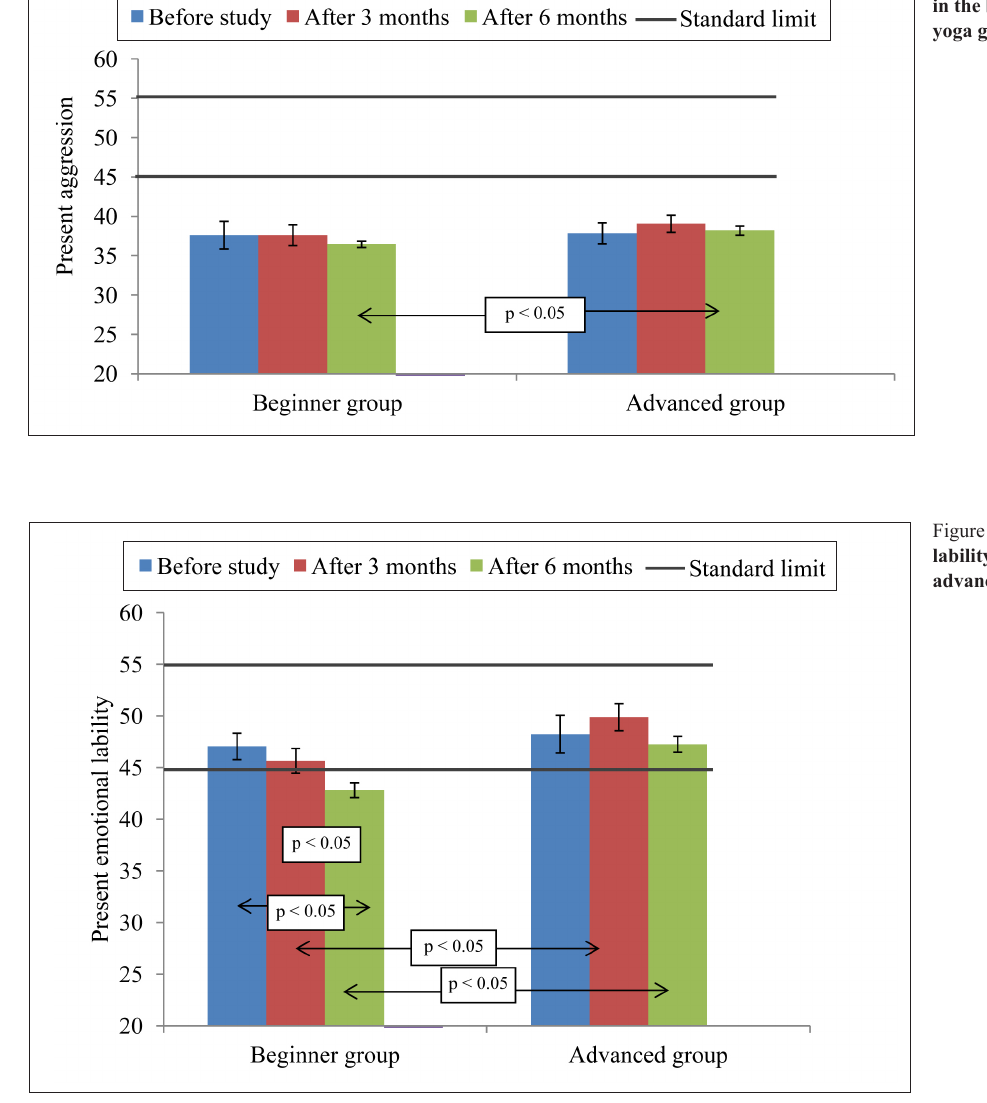
Figure 4. Present aggression in the beginner and advanced yoga groups